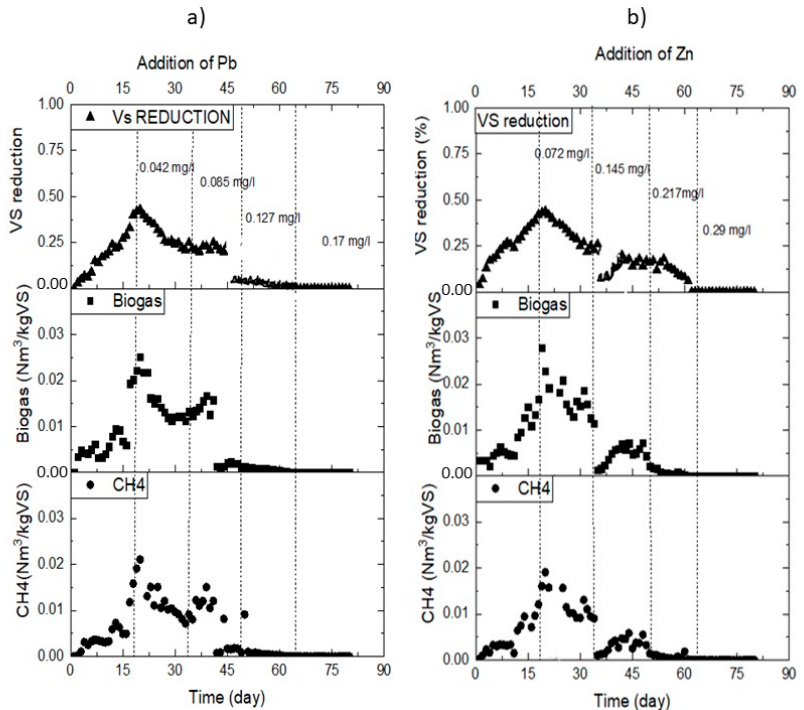
Figure 4. ( a )—Impact of Pb on the anaerobic digestion performance; ( b )—Impact of Zn on the anaerobic digestion performance